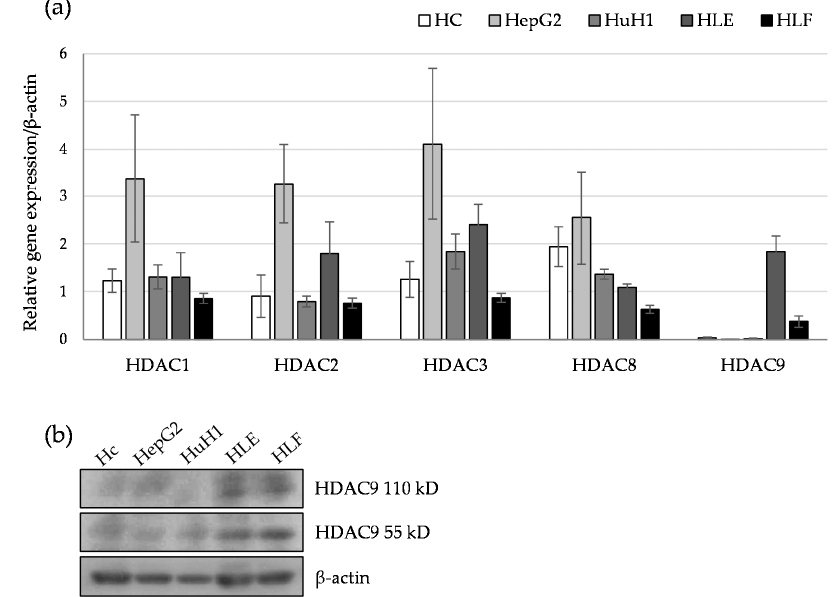
Figure 1. Differential expression of histone deacetylases (HDACs) in differentiated and undifferentiated hepatocellular carcinoma (HCC) cell lines. ( a ) Relative gene expression levels of HDAC1, HDAC2, HDAC3, HDAC8, and HDAC9 compared to a house keeping gene ( β -actin) were determined in two differentiated (HepG2 and HuH1) and two undifferentiated (HLE and HLF) type HCC cell lines by quantitative PCR analysis ( n = 3). The human hepatic cell line (Hc) was used as a non-transformed liver cell. ( b ) Western blot analysis of HDAC9 and β -actin as a protein loading control. Uncropped western blot figures in Figure S4.